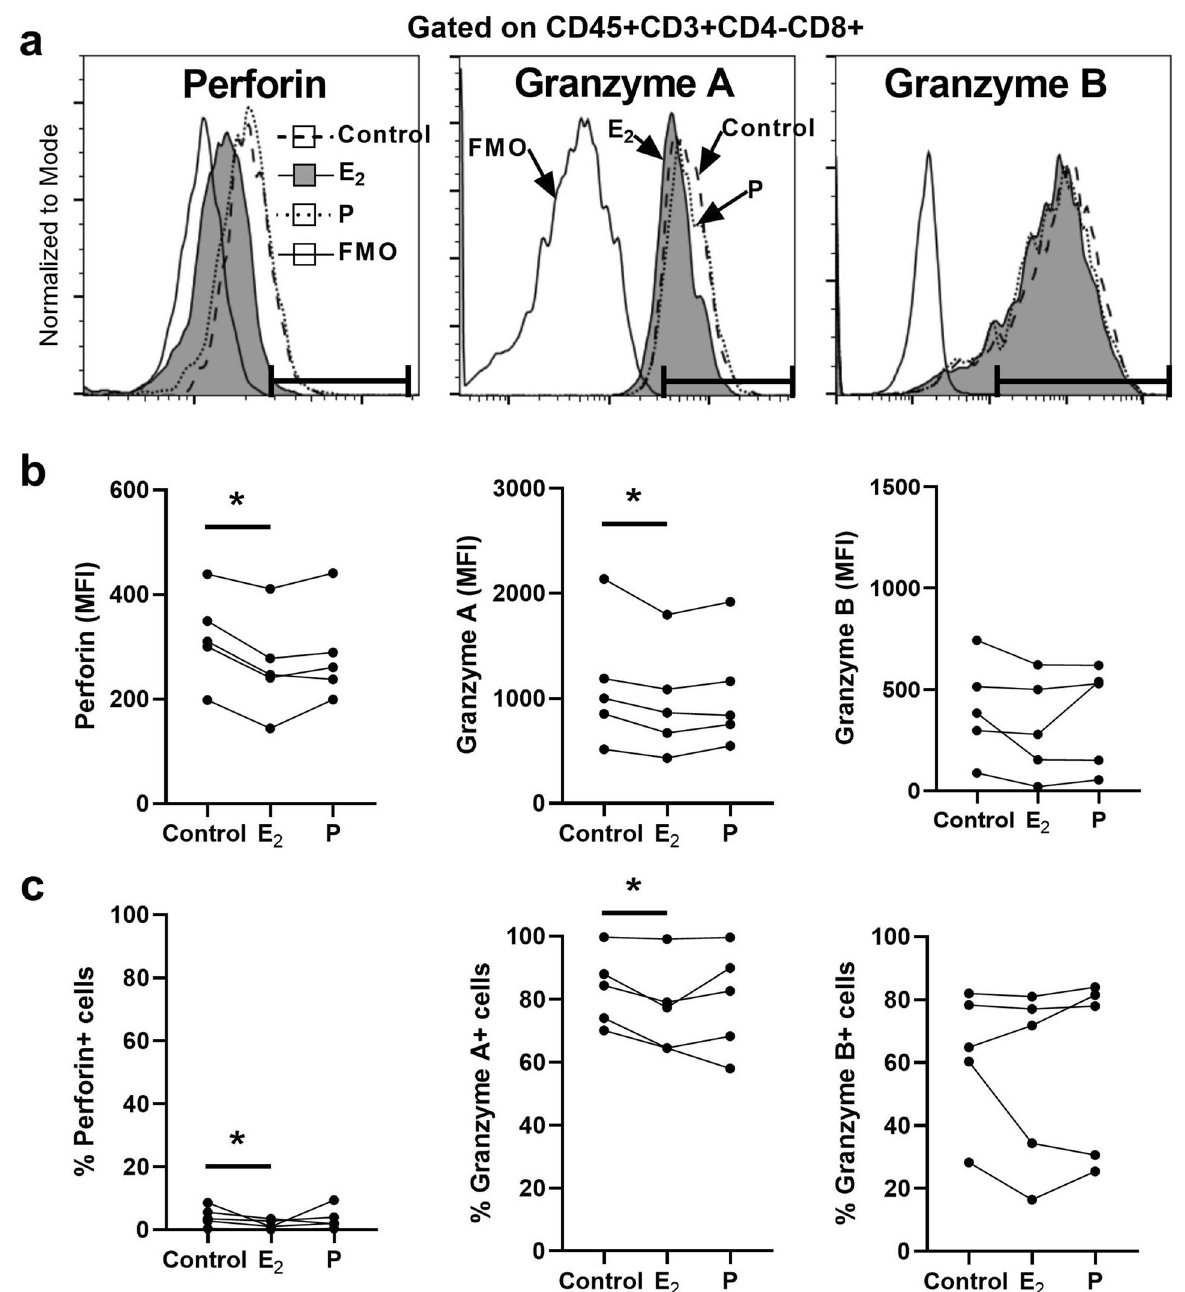
Figure 2. Effect of E 2 and P on intracellular cytotoxic molecules in endometrial CD8+T cells. Mixed cell suspensions from endometrial tissues were pre-treated with E 2 (5 × 10 −8 M), P (1 × 10 −7 M) for 48 h and stained for the intracellular cytotoxic molecules perforin, granzyme A and granzyme B for analysis by flow cytometry. ( a ) Representative histograms of intracellular perforin (left), granzyme A (middle) and granzyme B (right) expression in endometrial CD8+T cells treated with E 2 and P. Gate boundaries (horizontal line) were set by fluorescence minus one (FMO) to indicate the gating of positive cells. ( b ) Median fluorescence intensity (MFI) of perforin (left), granzyme A (middle), granzyme B (right) and ( c ) percentage of perforin+ (left), granzyme A+ (middle), granzyme B+ (right) in endometrial CD8+T cells following incubation with E 2 and P. Each dot represents a different patient (n = 5). * P < 0.05; Friedman test with Dunn’s multiple comparisons